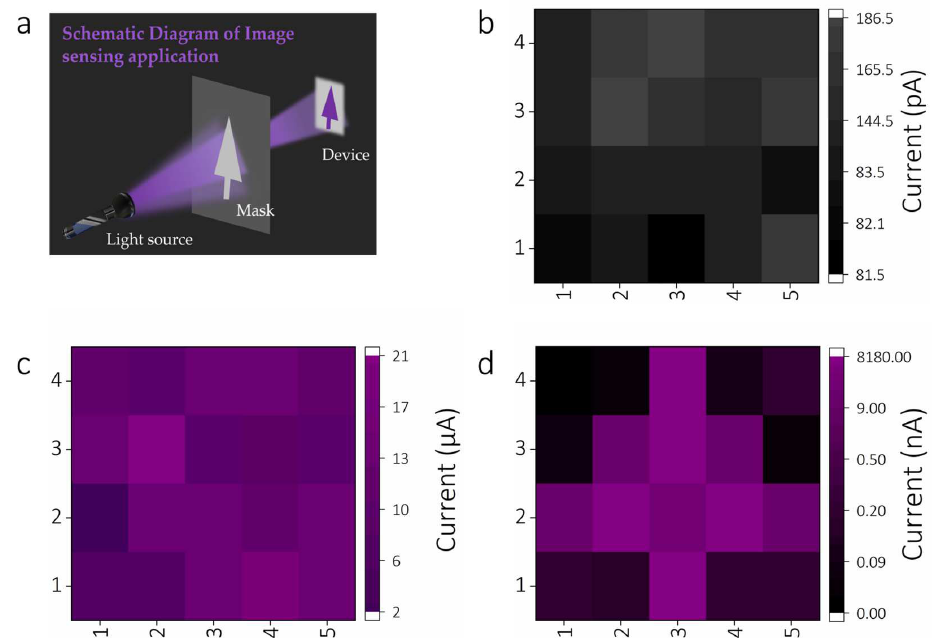
Figure 5. ( a ) Schematic diagram of the SBUV imaging test; 2D current contrast diagrams showing the current of the device elements of all 5 × 4 devices ( b ) in the darkness and ( c ) under 254 nm light (500 μW/cm 2 ); ( d ) 2D current contrast diagram of the device array, showing the solar-blind ultraviolet imaging function.